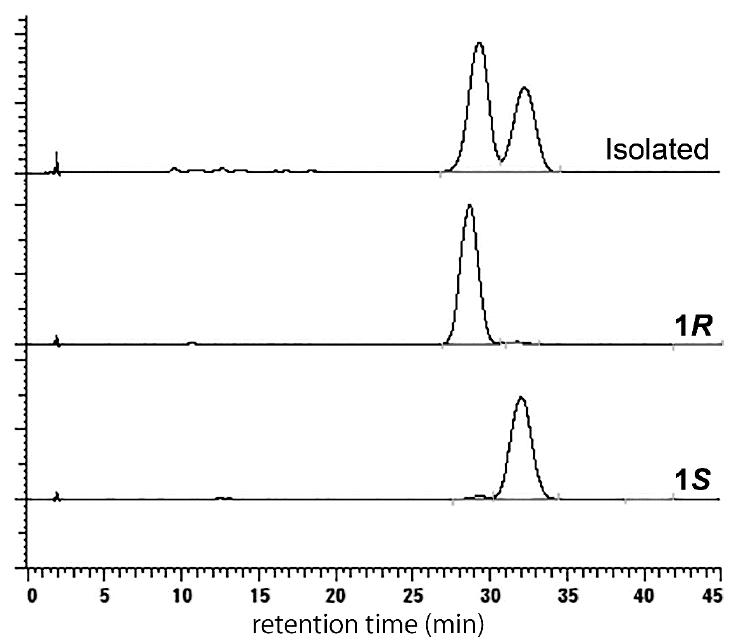
Figure 3. HPLC separation of diastereomers of 1 . Conditions: column, COSMOSIL Cholester (4.6 × 150 mm); mobile phase, 5% aq. methanol containing 0.1% trifluoroacetic acid; flow rate, 0.5 mL/min; detection, 280 nm.